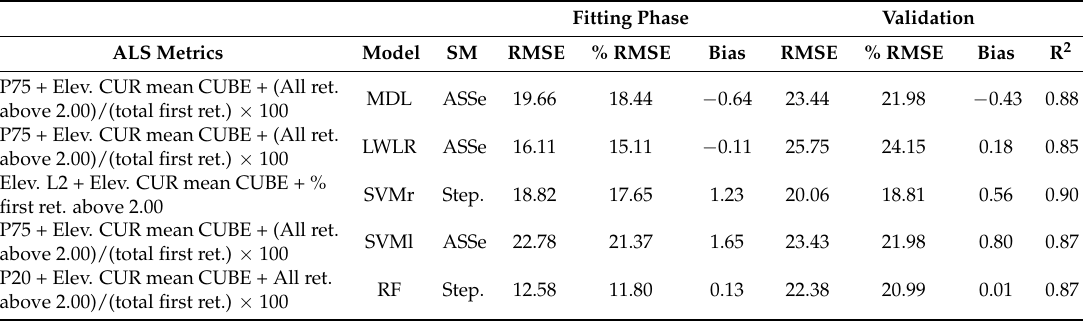
Table A15. Summary of the W models using 2016 ALS data. Validation results in terms of RMSE (tons ha − 1 ), %RMSE, and bias (tons ha − 1 ) and R 2 . SM refers to selection method; Step. stands for Stepwise both and forward; SVMr. refers to support vector machine with radial kernel; SVM l. refers to support vector machine with linear kernel; ret. refers to